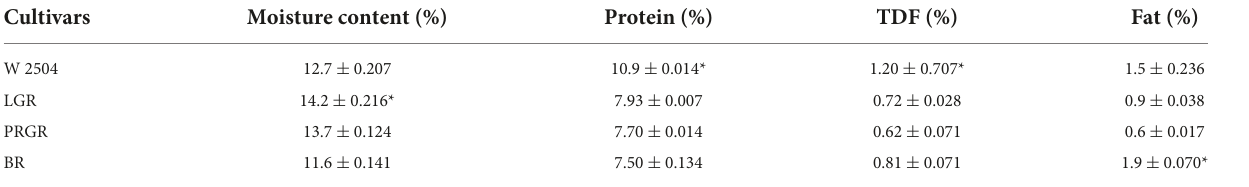
TABLE 1 Physicochemical index of different rice and common wheat.